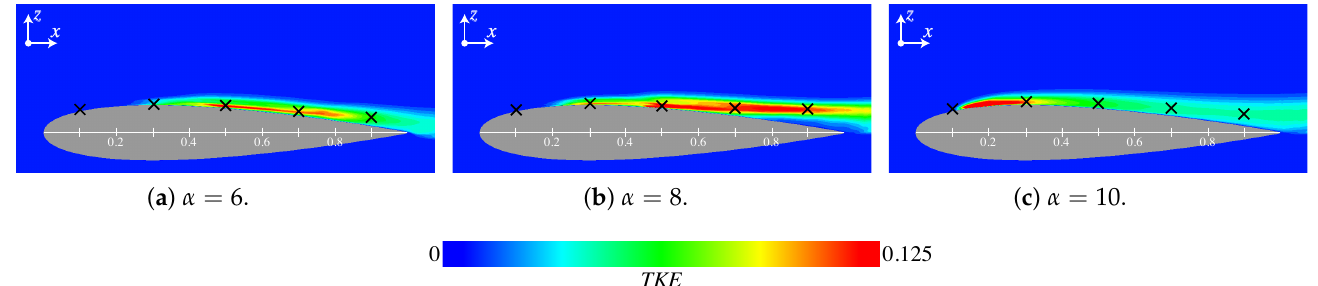
Figure 17. Turbulent kinetic energy (TKE) distributions in the Burst cases.